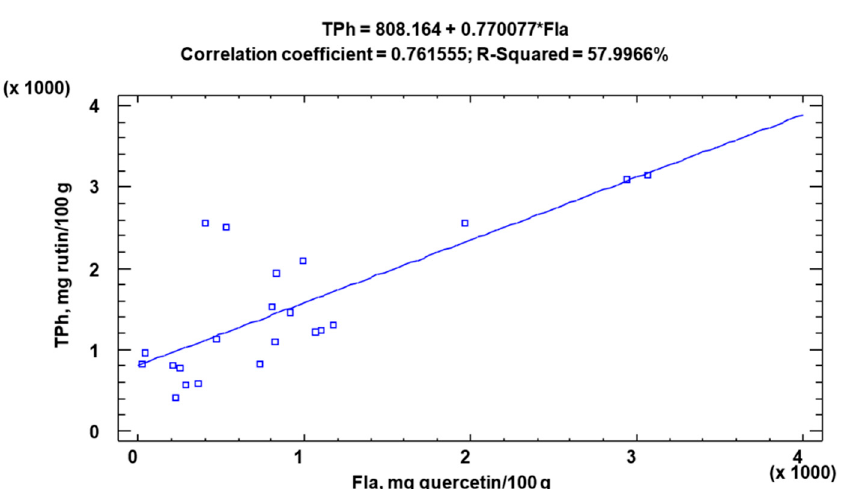
Figure 2. Correlation study between total Polyphenols (TPh) and Flavonoids (Fla). The maximum TPh and Fla values were observed for the Terminalia chebula and Ter- minalia arjuna samples, with 2819 and 2543 mg rutin hydrate/100 g, respectively for TPh, and 2456 and 1950 mg quercetin/100 g, respectively for Fla. However, the ANOVA test did not reveal significant statistical differences between the different fruit species ( p > 0.05). The highest TPh and Fla contents were recorded for the Combretaceae and Anacar- diaceae and for the Combretaceae and Rhamnaceae families, respectively ( p > 0.05). Com- parable TPh contents in the Rhamnaceae, Cucurbitaceae and Combretaceae species have been detected in previous research [15–19]. Table 3 shows the concentrations of the minerals analyzed in the samples, which ranged from 1432.59 to 7927.99 mg/100 g ( p < 0.05), with a mean value of 3730.24 mg/100 g. The highest values were observed for Buchanania lanzan (PC + SC), Terminalia arjuna (KE) and Terminalia catappa (KE). Comparable mineral contents were observed in the Ter- minalia species, analyzed by X-ray fluorescence [19]. However, markedly different min- eral contents were observed in the African Cucurbitaceae species, possibly due to climatic variations [20–22].